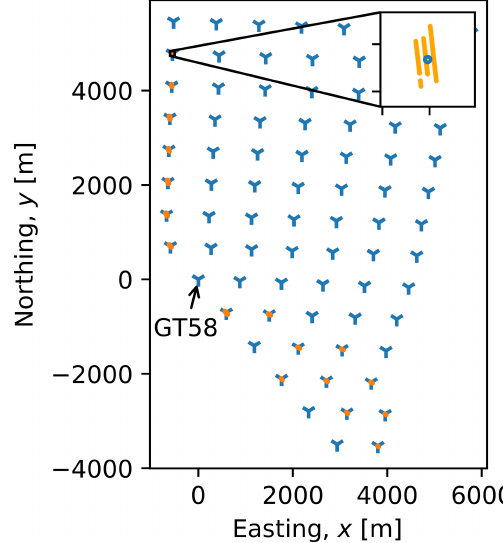
Figure 8. Result of the HT. The blue symbols represent the turbine layout. The orange dots are the hard target measurements L ht . In the upper right corner is a zoom in for the northernmost hard target measurements.